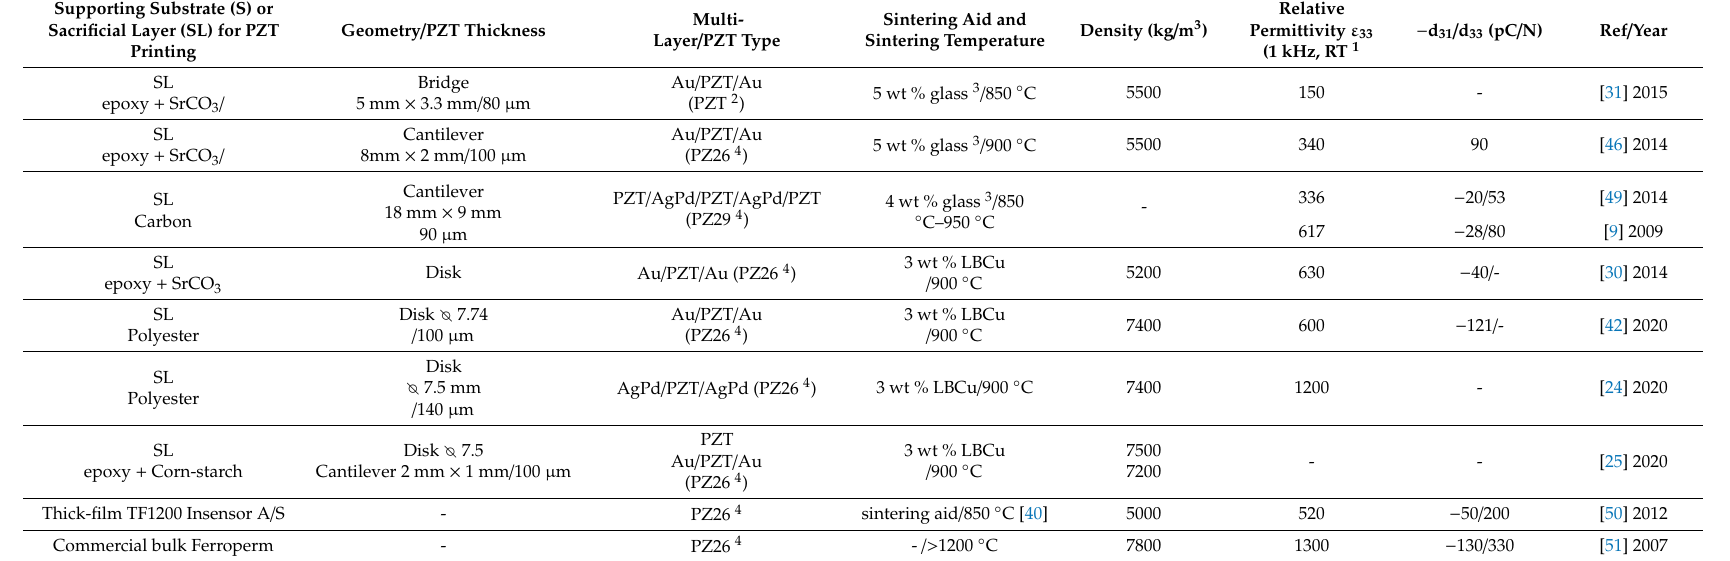
Table 2. Comparison of the properties of PZT films used in thick-film ceramic MEMS [9,24,25,30,31,40,42,46,49–51]. Supporting Substrate (S) or Sacrificial Layer (SL) for